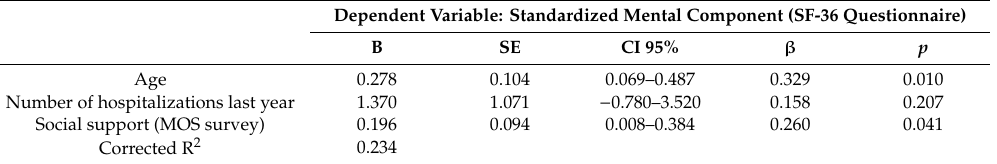
Table 4. Regression model for perceived mental quality of